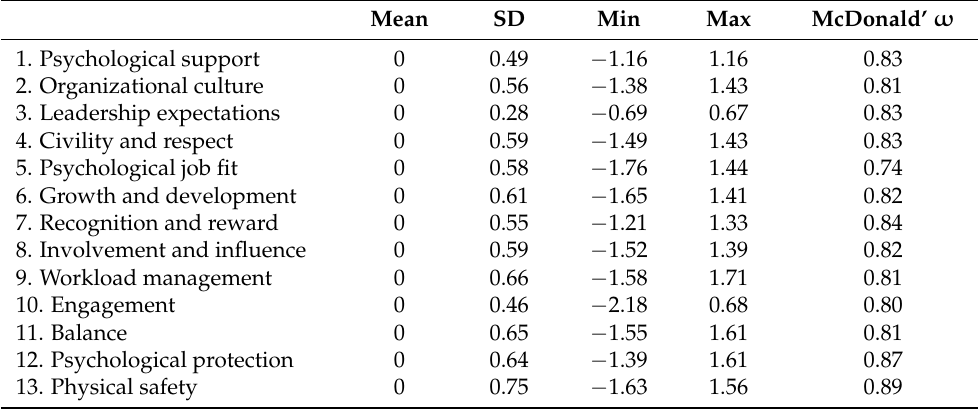
Table 1. Descriptive statistics and reliability coefficients of the 13 GM@W factors ( n = 4066). Mean SD Min